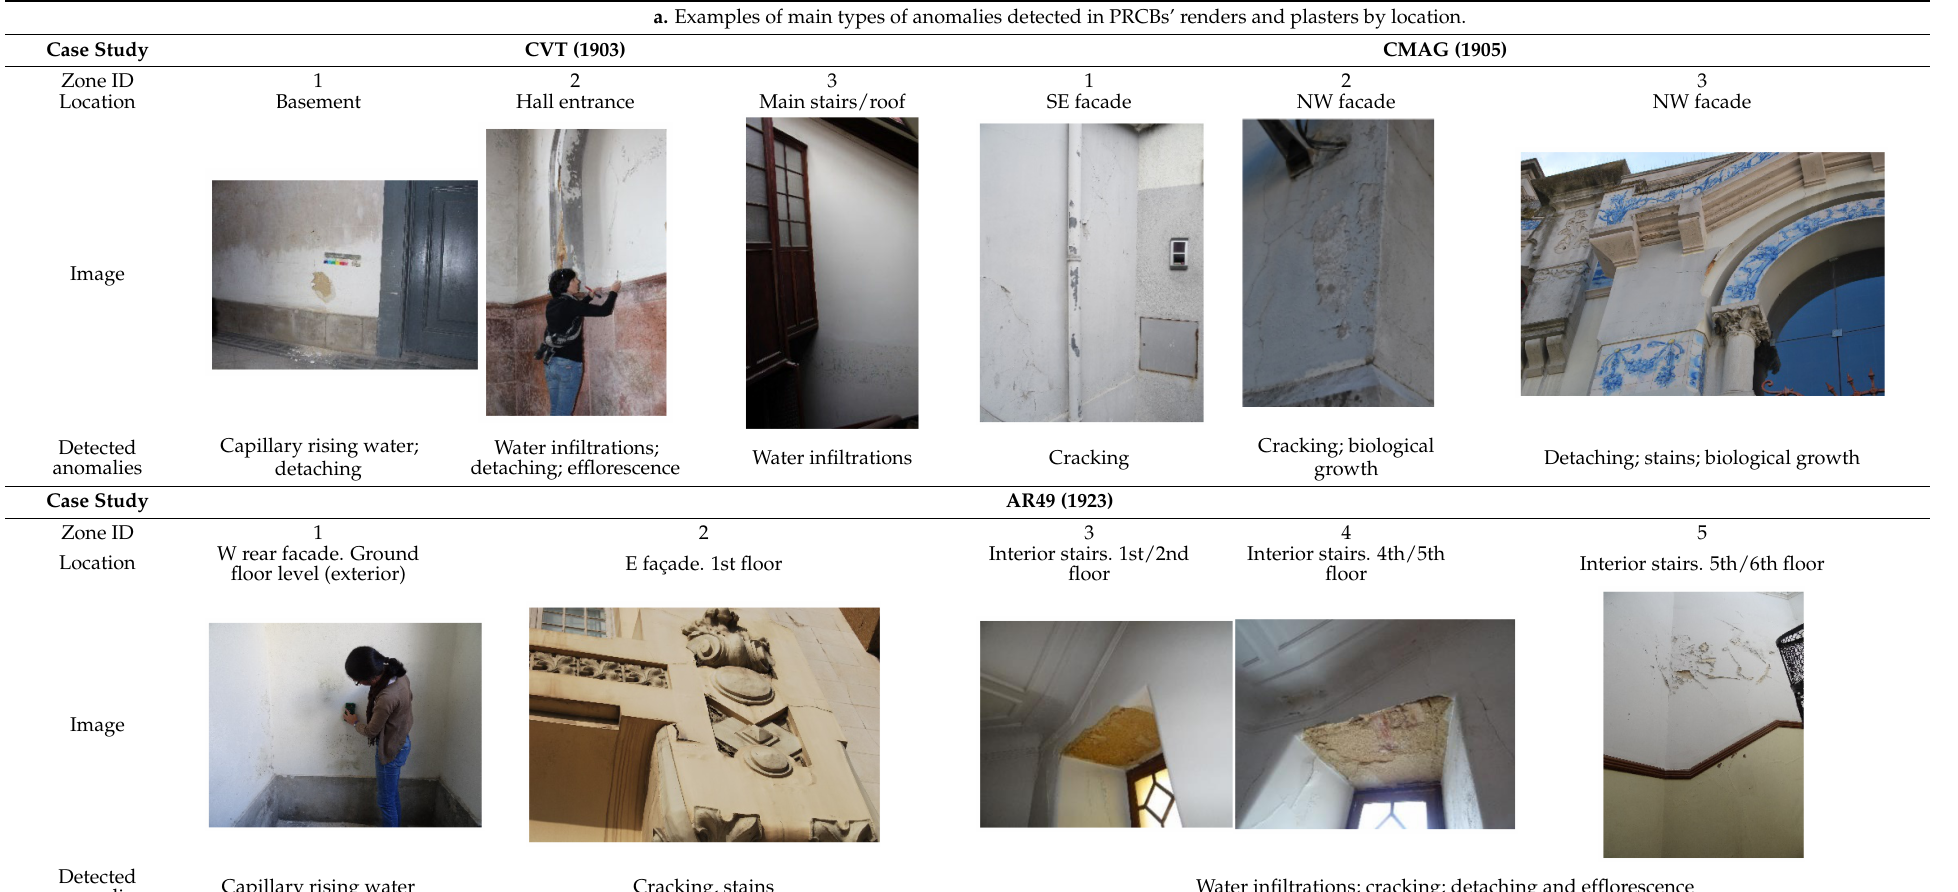
Table 6. Examples of main types of anomalies detected in renders and plasters of the cases